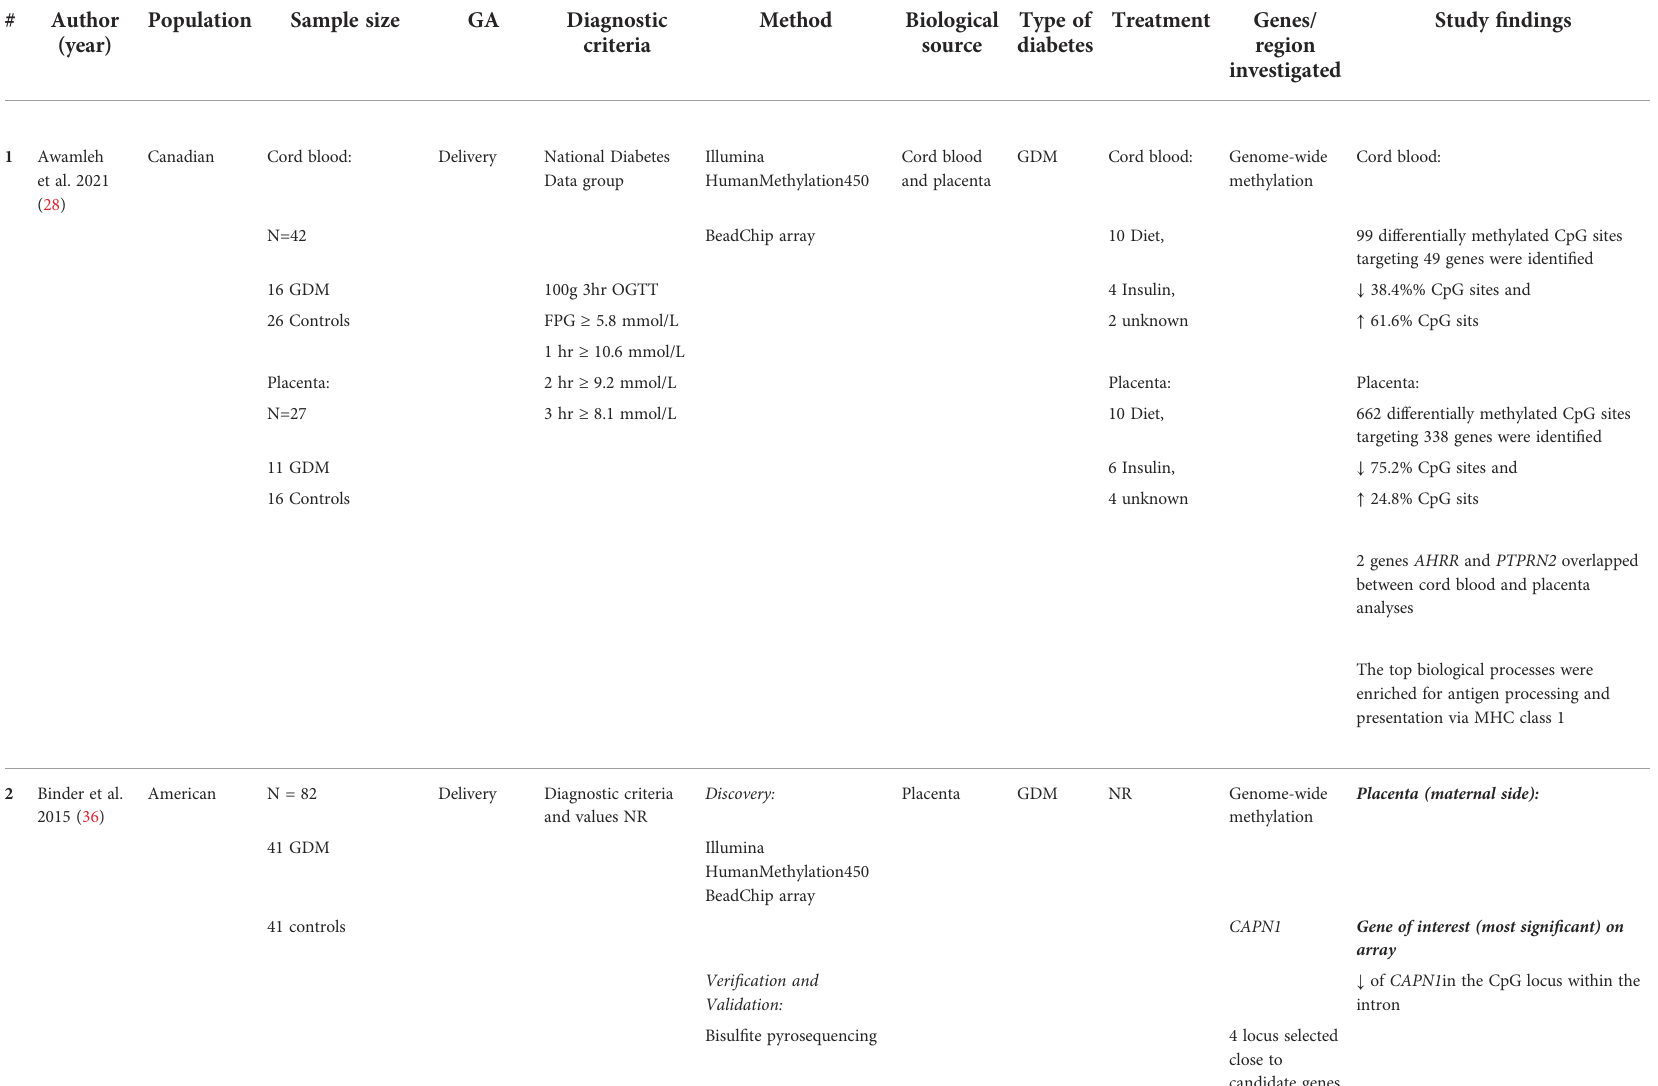
TABLE 1 DNA methylation pro fi ling in pregnancies complicated by